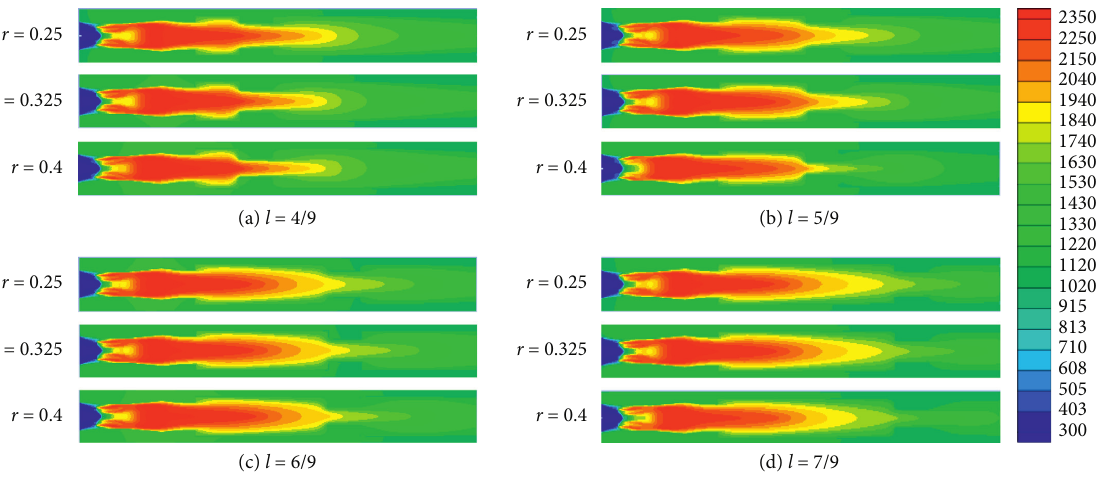
Figure 6: Spatial distribution of temperature at l � 4/9.